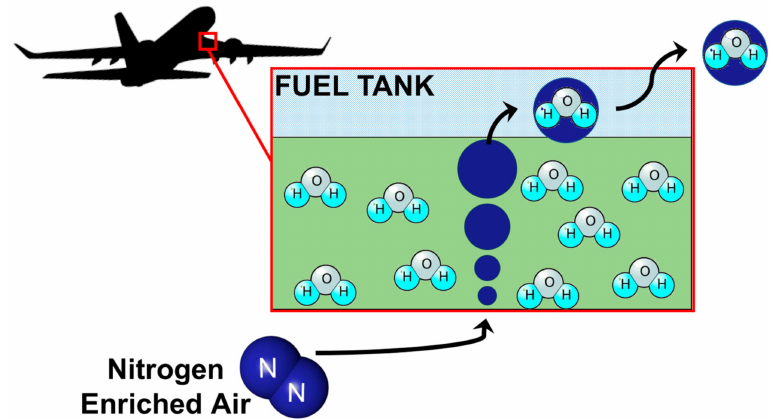
Figure 1. Schematic of the nitrogen enriched air (NEA) pumping process. NEA is pumped from the bottom of the fuel tank. The dry NEA absorbs water from the fuel and ullage, and exits the system through a pressure